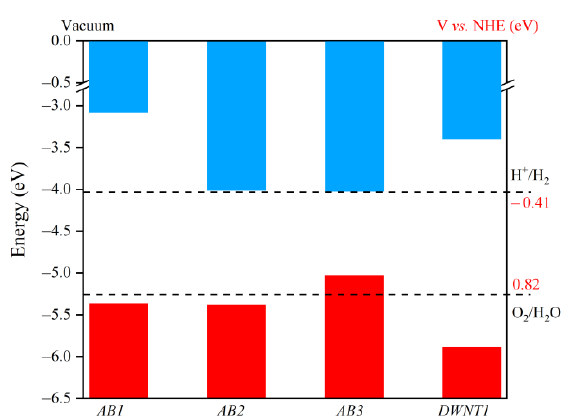
Figure 3. The potential of the CBM (blue region) and VBM (red region) of WSSe bilayer with different stacking patterns ( AB1 , AB2 , and AB3 ) and WSSe DWNT1 , with respect to the vacuum level (labeled as 0 eV). The dashed lines mark the oxidation potential of O 2 /H 2 O and reduction level of H + /H 2 . The pH is set to 7.